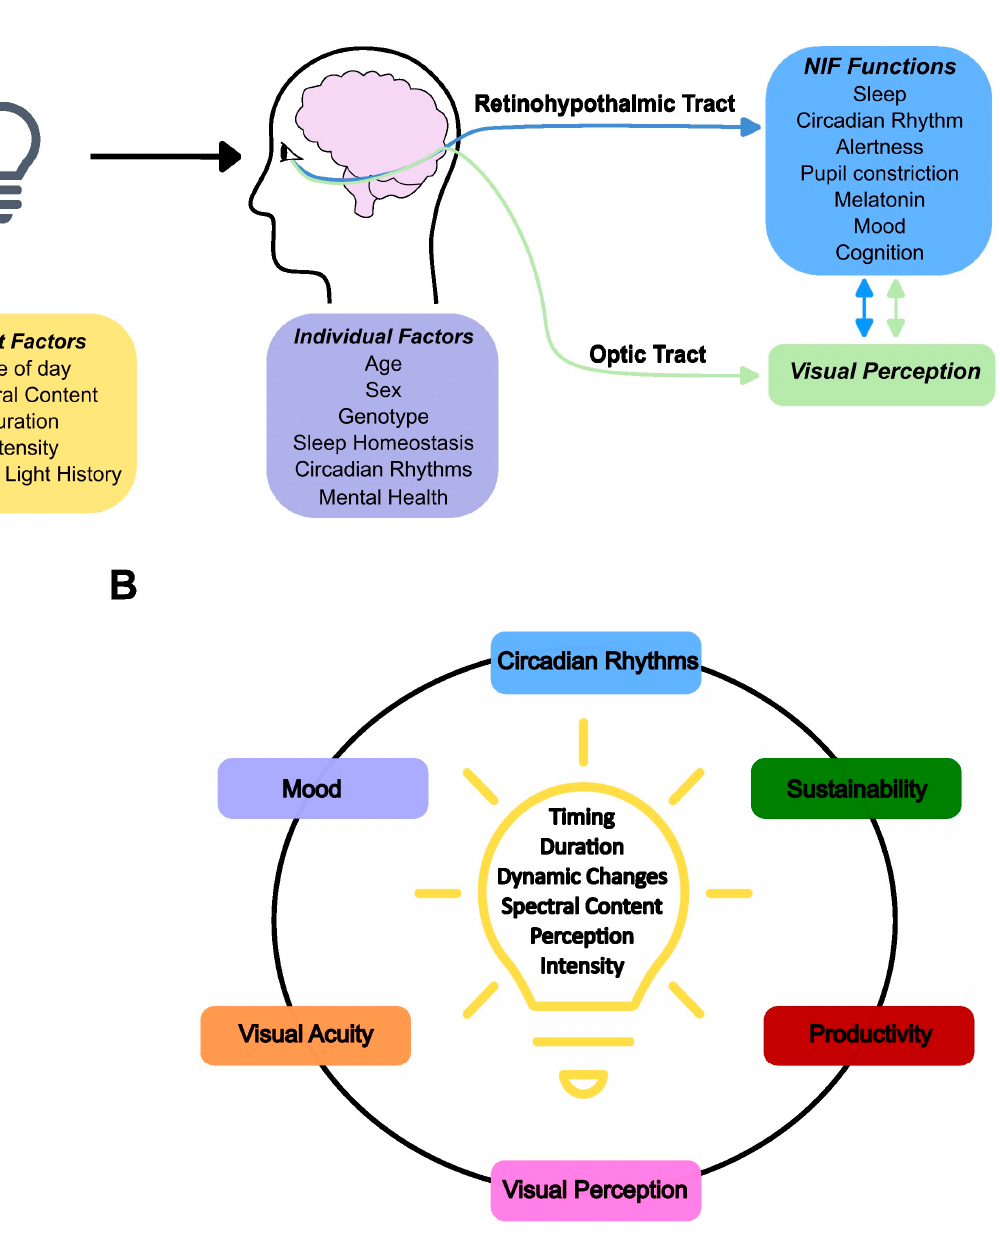
Figure 3. Light’s impact image forming (IF) and non-image forming (NIF) pathways. ( A ) Light signal reaches the central nervous system via the retinohypothalamic and optic tracts of the optic nerve to affect IF and NIF functions. Light impact on NIF functions depends on light factors and individual factors. ( B ) The industrial concept of integrative lighting aims to design individually tailored dynamic lighting accounting for visual perception and acuity, together with light’s impact on NIF functions, including mood, circadian rhythms, productivity (i.e., attention/alertness), and environmental sustainability. NIF’s consideration of integrative lighting largely lacks a strong scienti fi c basis.